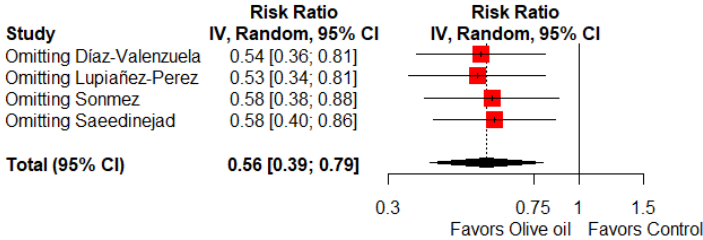
Figure 5. Sensitivity analysis (forest plot). The red squares represent the point estimate of the effect size and sample size. The lines on either side of the box represent a 95% confidence interval (CI). The (CI). The rhombus represents pooled results [17–20]. rhombus represents pooled results